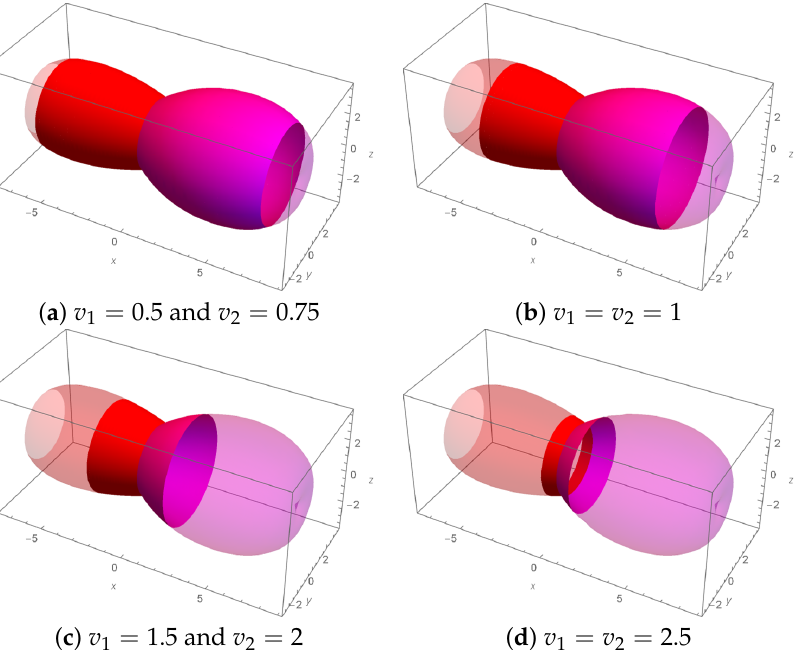
Figure 18. Surface revolution at x -axis of two connected cubic fractional Bézier curves.